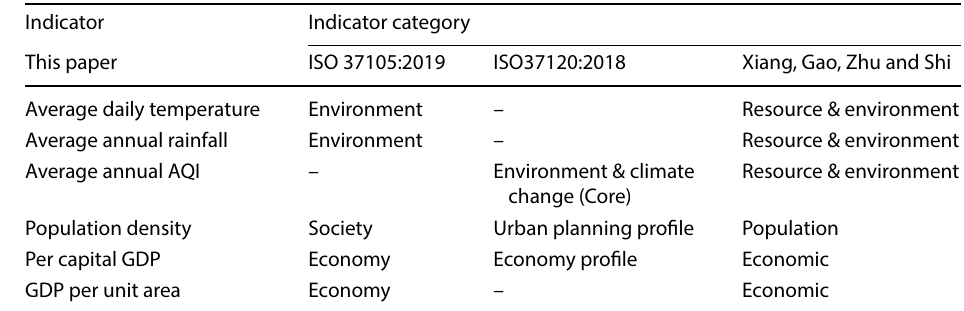
Table 4 Indicators